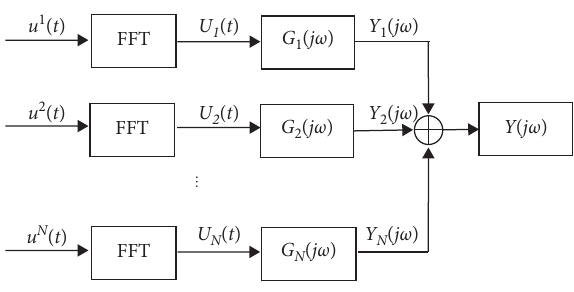
Figure 1: The expression of